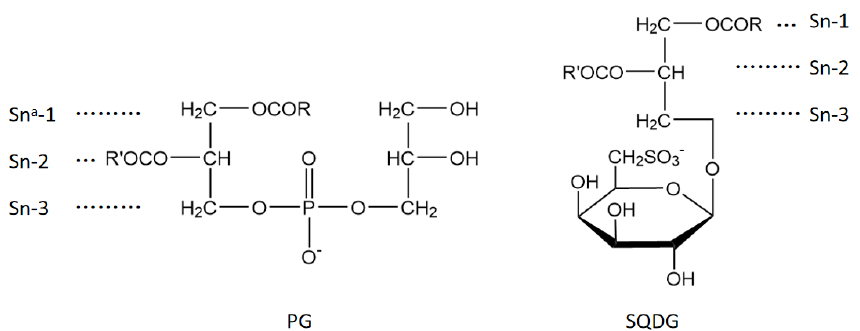
Figure 2. Structural formulas of phosphatidylglycerol (PG) and sulfoquinovosyldiacyglycerol (SQDG). The R groups and R’ represent various fatty acid chains of different lengths. a Stereospe- cifically numbering (Sn).